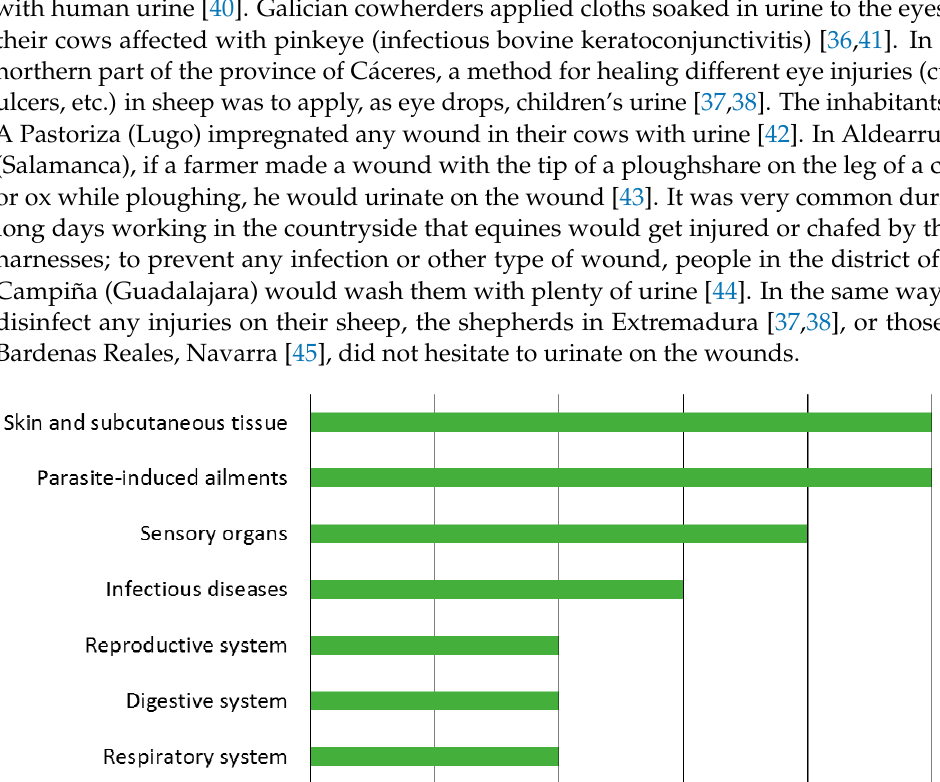
Figure 1. Number of empirical remedies documented for the treatment of specific domestic animal groups.